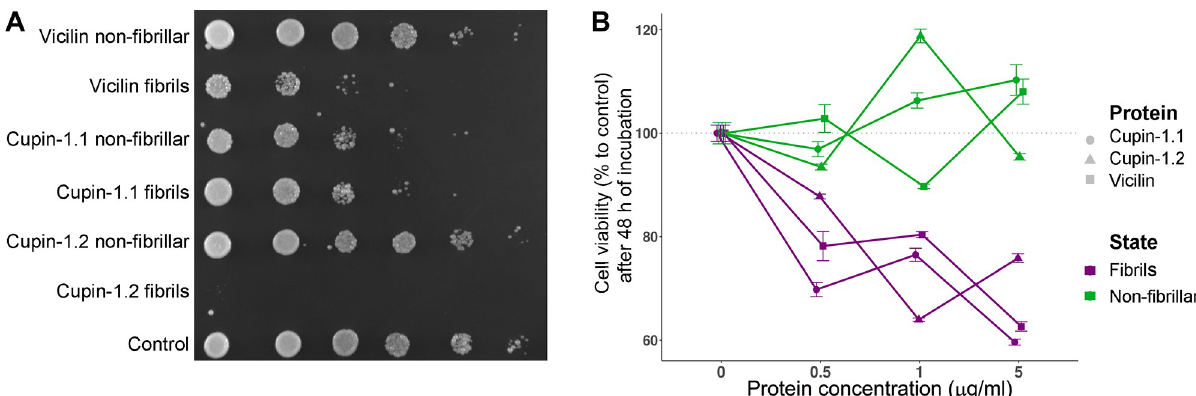
Fig 6. Vicilin fibrils are toxic for yeast and mammalian cells. (A) Analysis of the Vicilin, Cupin-1.1, and Cupin-1.2 fibrils and nonfibrillar aggregates toxicity for yeast cells. A series of 10-fold dilutions of the liquid yeast culture is shown. Picture was taken after 48 h of incubation at 30˚C. (B) Analysis of the Vicilin, Cupin-1.1, and Cupin-1.2 fibrils and nonfibrillar aggregates toxicity for mammalian cells. Dependence of the cell viability on the aggregates concentration is shown. Data were obtained after 48 h of incubation. Protein concentrations ( μ g/mL) are indicated. Scale bars correspond to the standard errors of the means. Values for the graph in Panel B are listed in S4